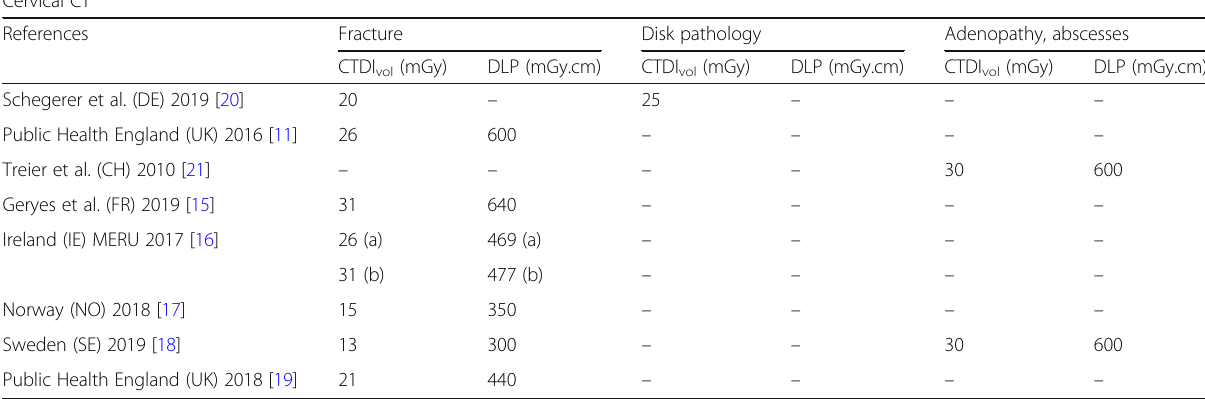
Table 3 DRL ci for cervical CT Cervical